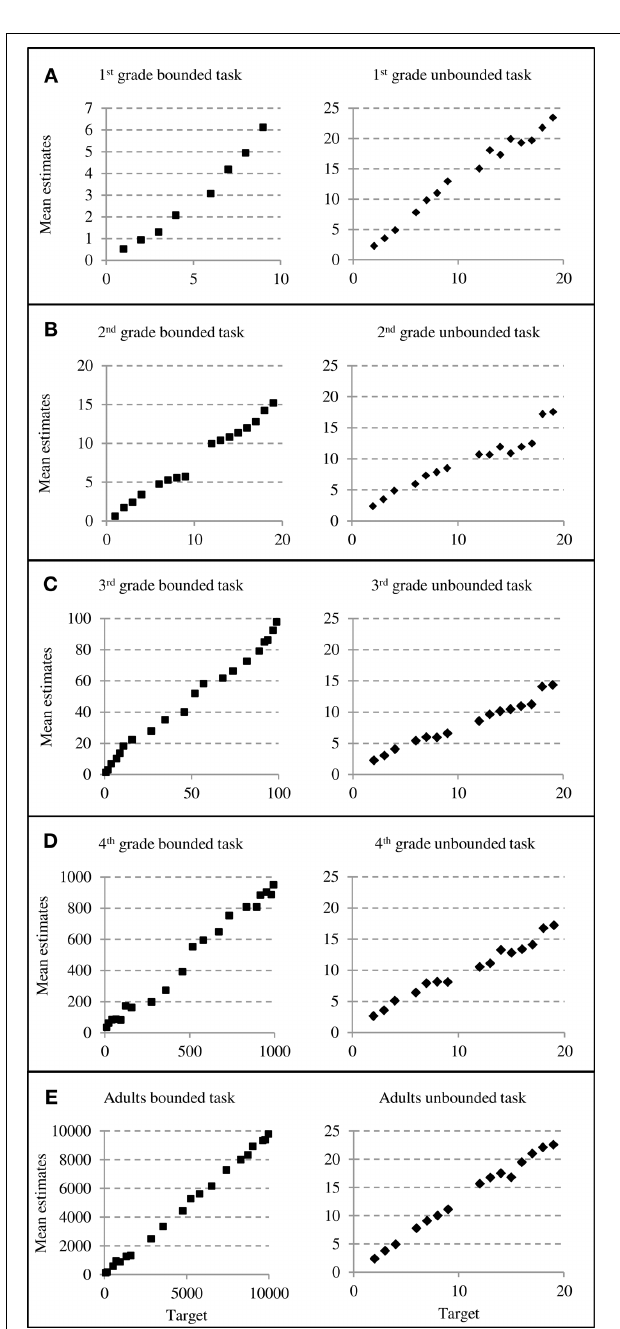
FIGURE 2 | Estimation patterns for both versions of the number line estimation task. The left column depicts bounded and the right column depicts unbounded number line estimates for all age groups ( grade one through adults: A – E)